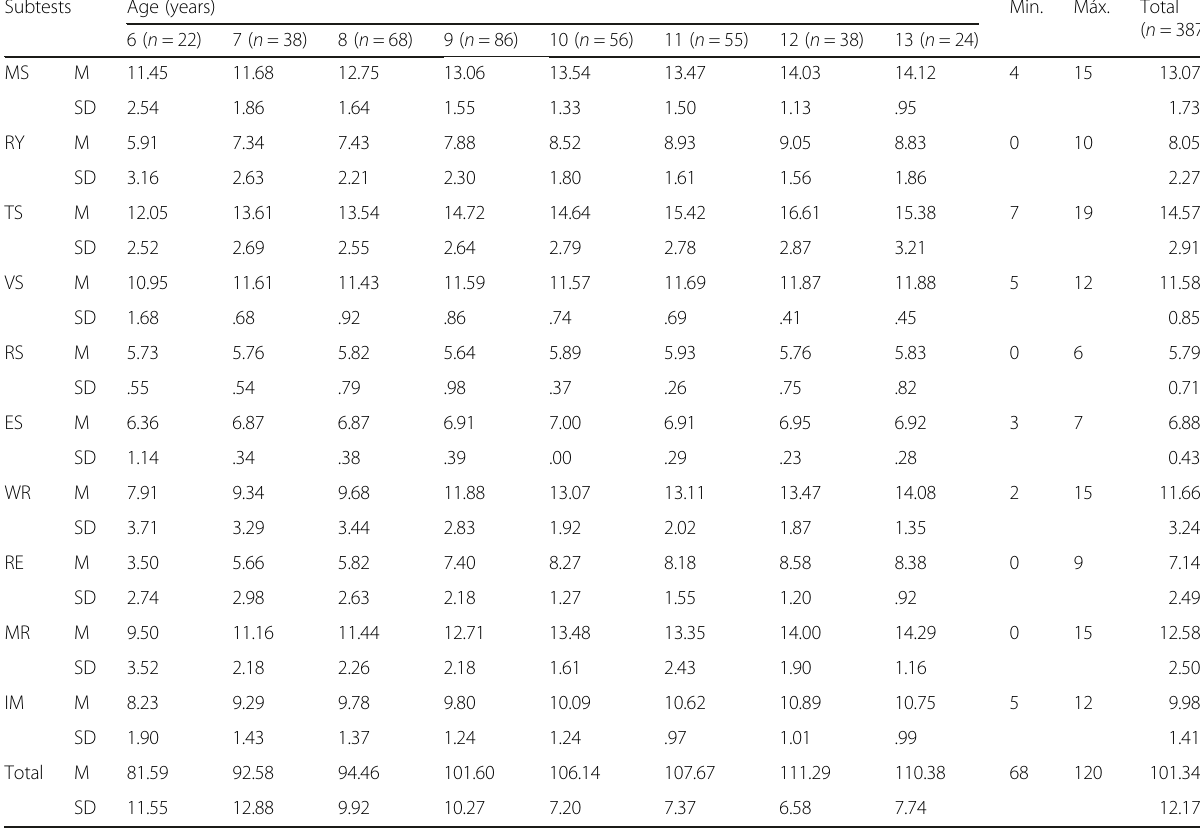
Table 2 Descriptive statistics of TLN-C subtests according age and sample total Subtests Age (years) Min. Máx.